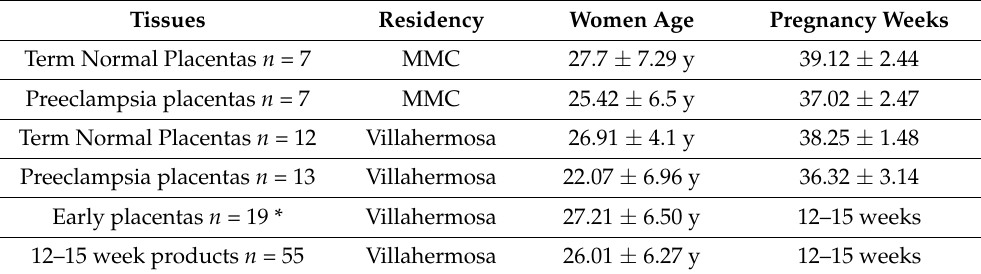
Table 1. Demographic data on the 94 women participating in this